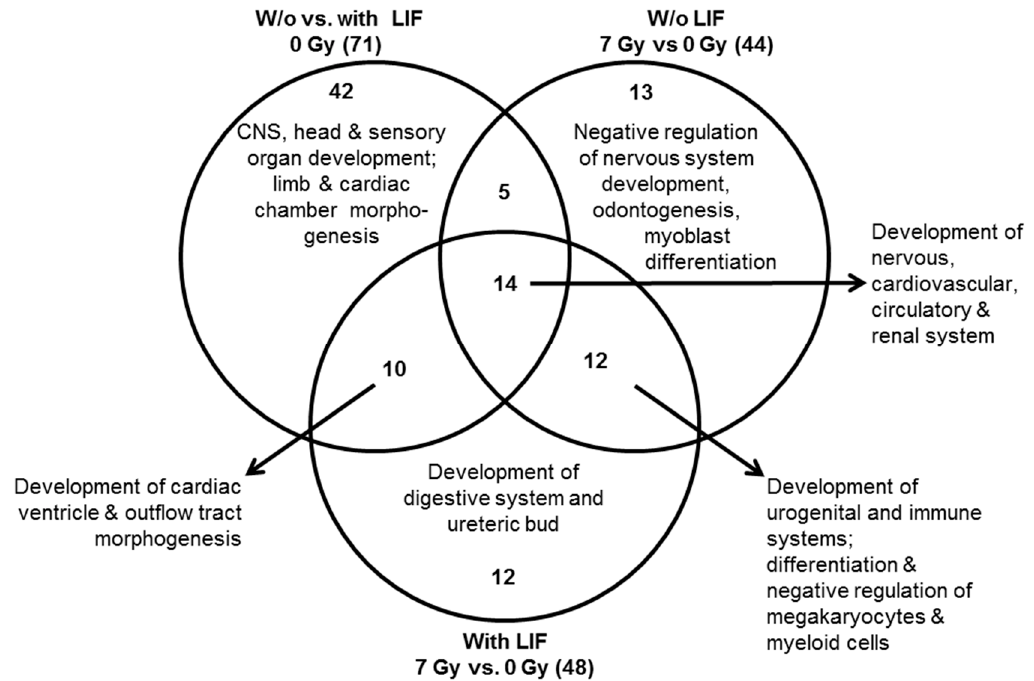
Figure 11. Venn diagram of biological processes altered by developmental genes and X-ray deregulated genes. The overlap analysis of gene ontology (GO) categories belonging to specific embryonic development shows the overrepresented categories amongst upregulated genes (fold change ≥ ± 2, p < 0.05, detailed data are shown in supplemental material).